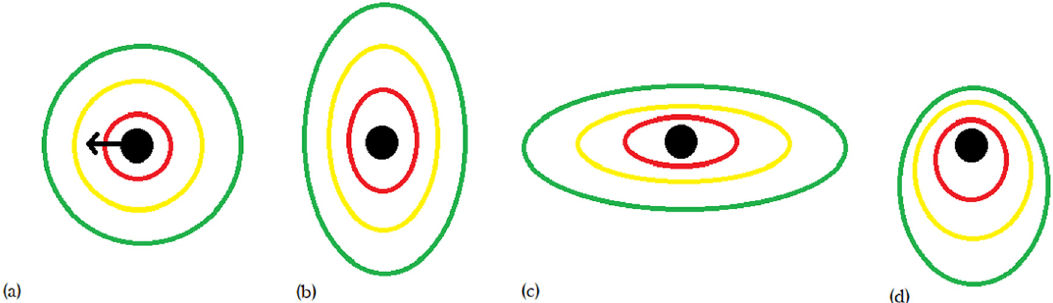
Figure 1: The model displays four social spacing shapes around a person, which dictate the di ff erent comfort zones: ( a ) concentric circles, ( b ) egg shaped, ( c ) elliptical, and ( d ) elliptical, which is skewed on the dominant side. Adapted from ref. [ 61 ]